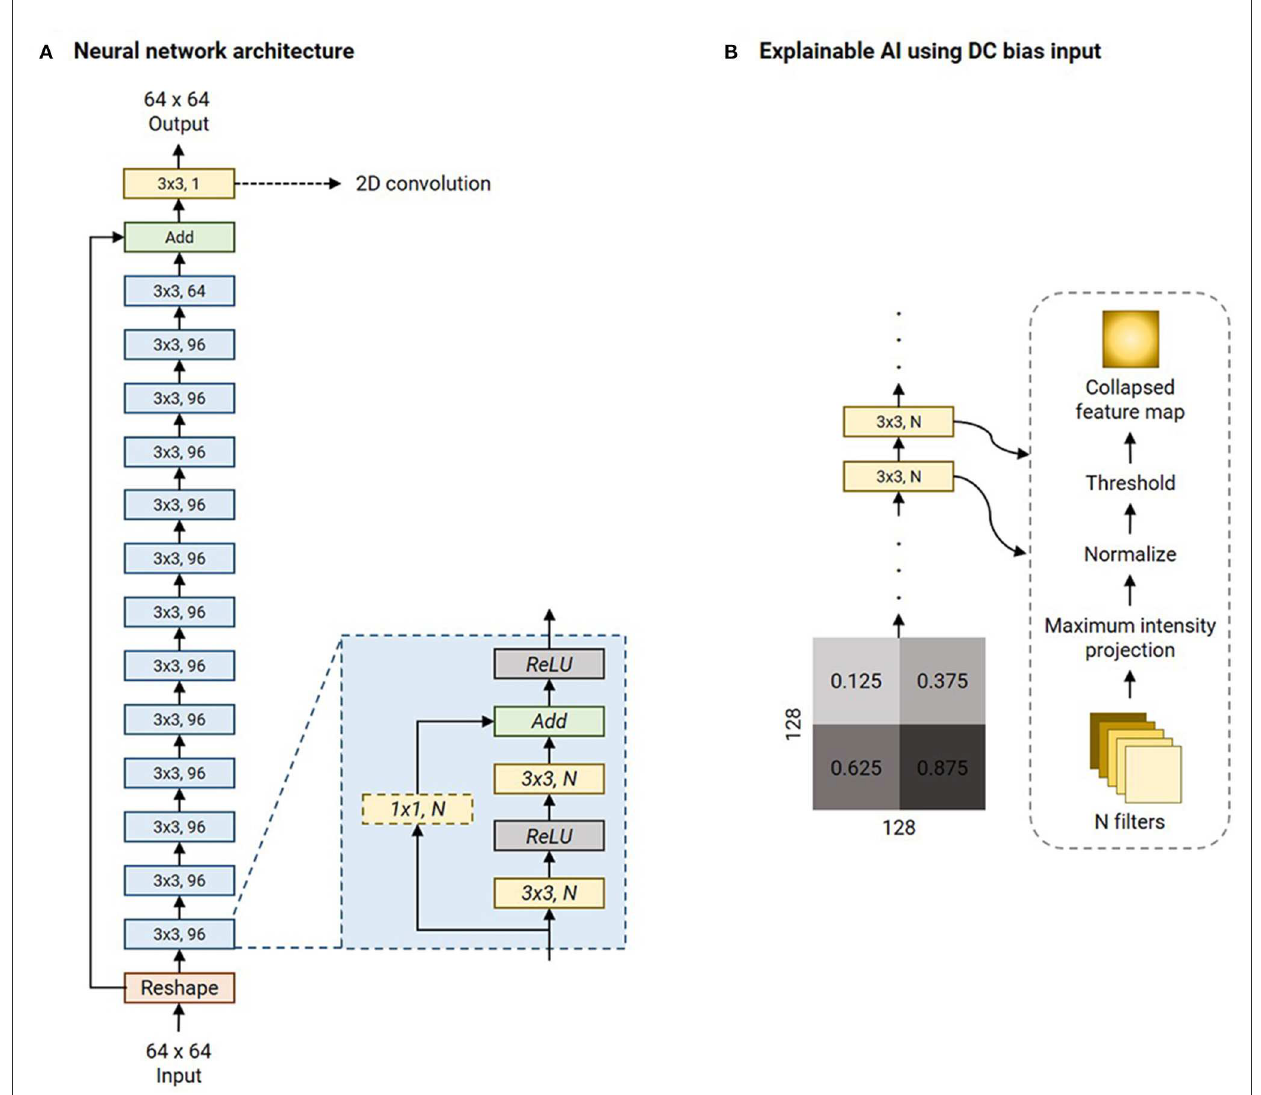
FIGURE3 Network architecture of the image denoising models and illustration of the explainable AI experiment. (A) The denoising model leverages multiple ResBlocks (blue) and minimizes the Mix-L + FTD loss (Section 2.2) using the Adam optimizer (refer Table 2 for initial learning rates). (B) The explainable AI experiment involves feeding a 128 × 128 DC biased input image. This is a collage of four 64 × 64 constant-valued image patches, as shown (numbers represent the intensity values). As the input is transformed by each 2D convolution layer, all the filter outputs are collapsed into a single image via maximum intensity projection. This is normalized to lie in the range [0, 1.0] and hard-thresholded to only retain values > 0.75. All the 2D convolution layers’ collapsed feature maps are collaged to investigate the mechanism of the denoising process by the network.